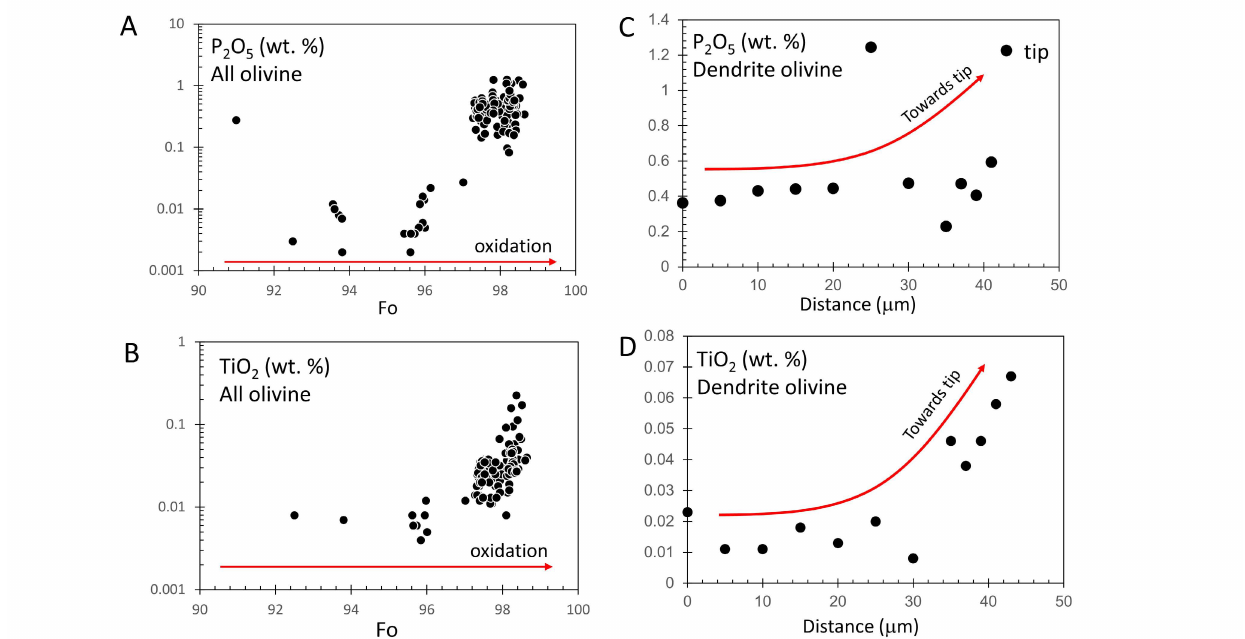
Figure 3: Case study of dendritic olivine from Kaua ‘ i, Hawai ‘ i. [A] and [B] P olivines. Data pertain to olivines from peridotite xenoliths and olivine phenocrysts within the host lava, including the swallowtail- shaped dendritic olivine in Figure 2B. [C] P of dendrite blade is on the right. [D] TiO the tip of the olivine